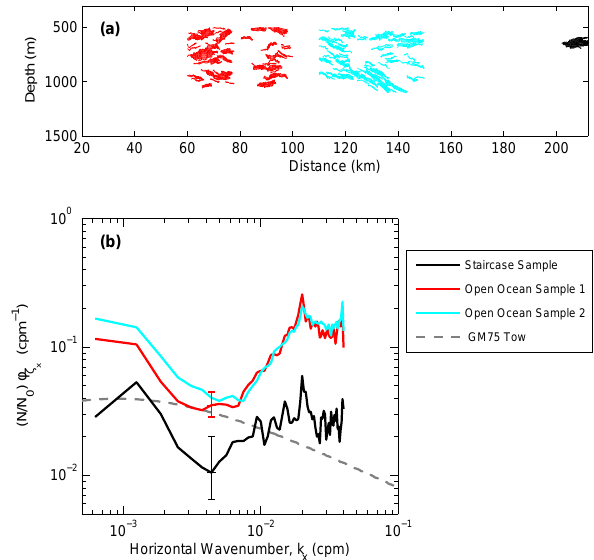
Fig. 11. (a) Reflections digitized for spectral analysis for ensem- bles in the staircase (black), and open ocean samples 1 (red) and 2 (cyan). (b) Ensemble-averaged slope spectra of selected horizons in the vicinity of the thermohaline staircase (black) and in the open ocean (red and cyan). All spectra are scaled by the average buoy- ancy frequency within the depth span of the horizons. Dashed line shows the slope spectrum inferred from GM75 tow spectrum (Katz and Briscoe, 1979) representing the average background internal wave energy for the average buoyancy frequency ( N = 1 . 9cph). The 95% confidence intervals are indicated for 160 and 25 degrees of freedom, respectively, for the open ocean and staircase spectra, assuming that every 6th reflector is de-correlated vertically (Krah- mann et al., 2008). The energy level in the staircase is anomalously low whereas those derived from other horizons scale to a level above the GM75